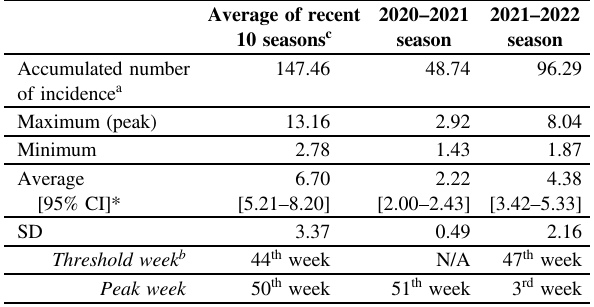
Table 1 Base statistics of norovirus incidence between 2010